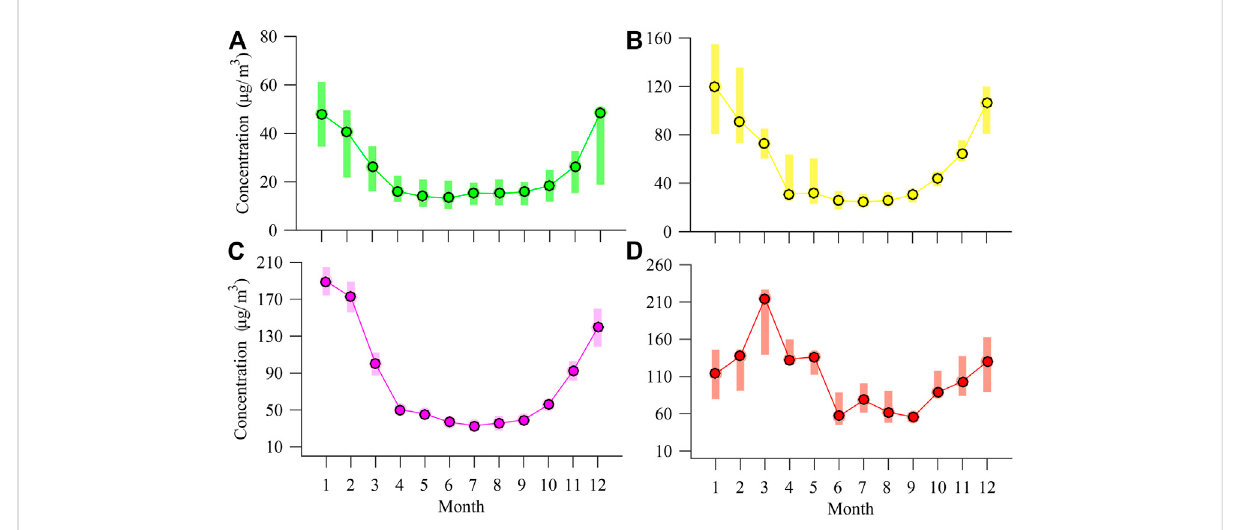
FIGURE 5 Box plots of monthly average PM 2.5 concentrations in (A) region I, (B) region Ⅱ , (C) region Ⅲ and (D) region Ⅳ of Xinjiang from 2013 to 2019.